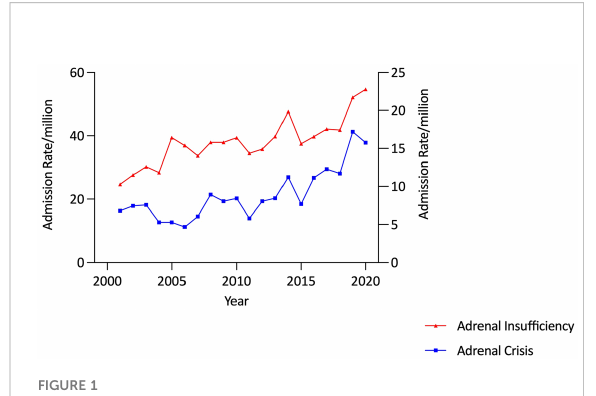
FIGURE 1 Adjusted adrenal insuf fi ciency and adrenal crisis admission rates, 10-24 years, Australia, 2000/1 to 2019/20.